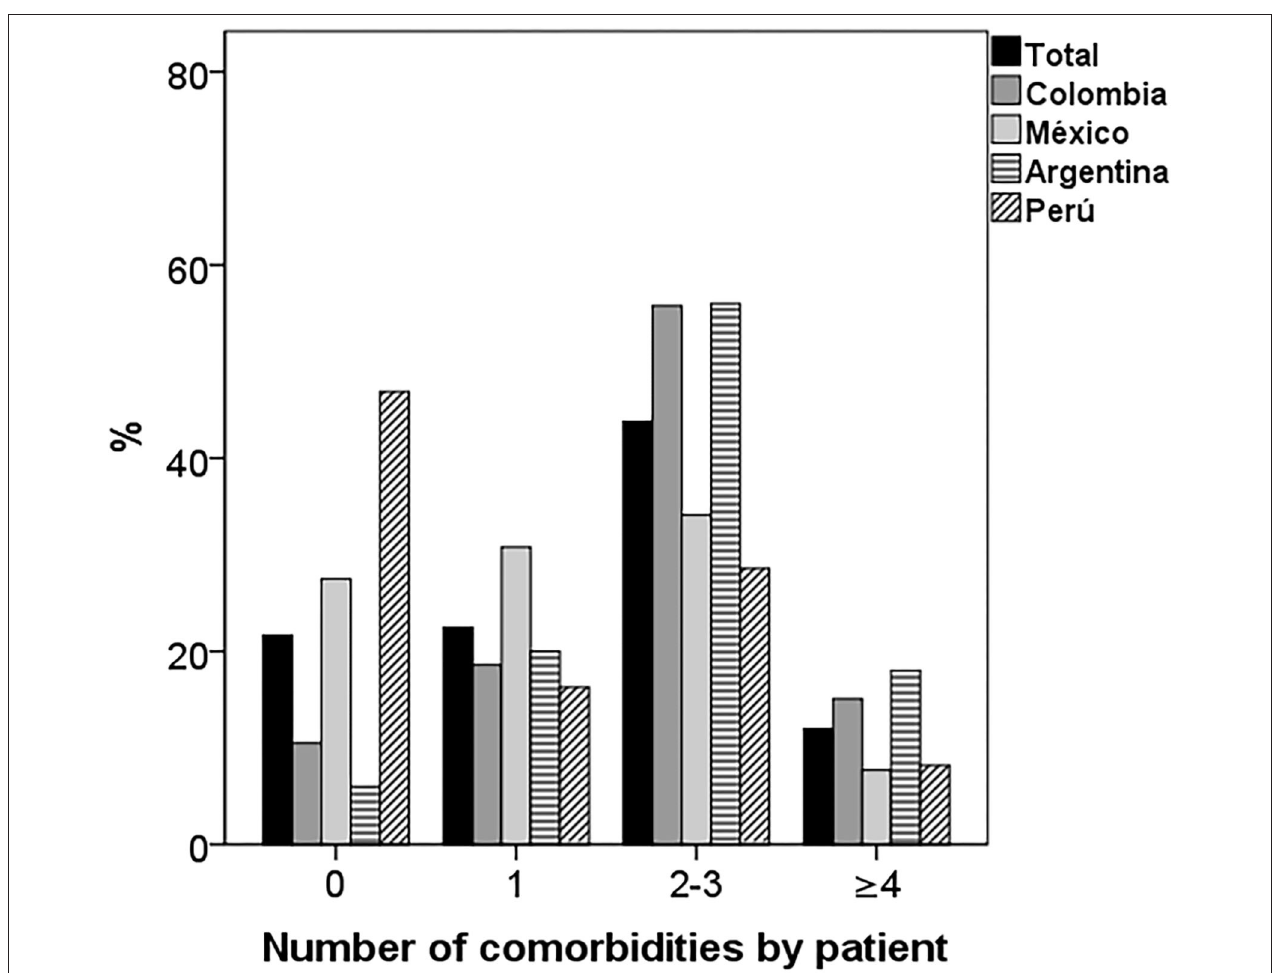
FIGURE 2 | Number of comorbidities per patient by country. There were significant differences in the distribution of comorbidities by country. Most of the patients from Peru and Mexico had one or no comorbidity and those from Colombia and Argentina two or three ( p <